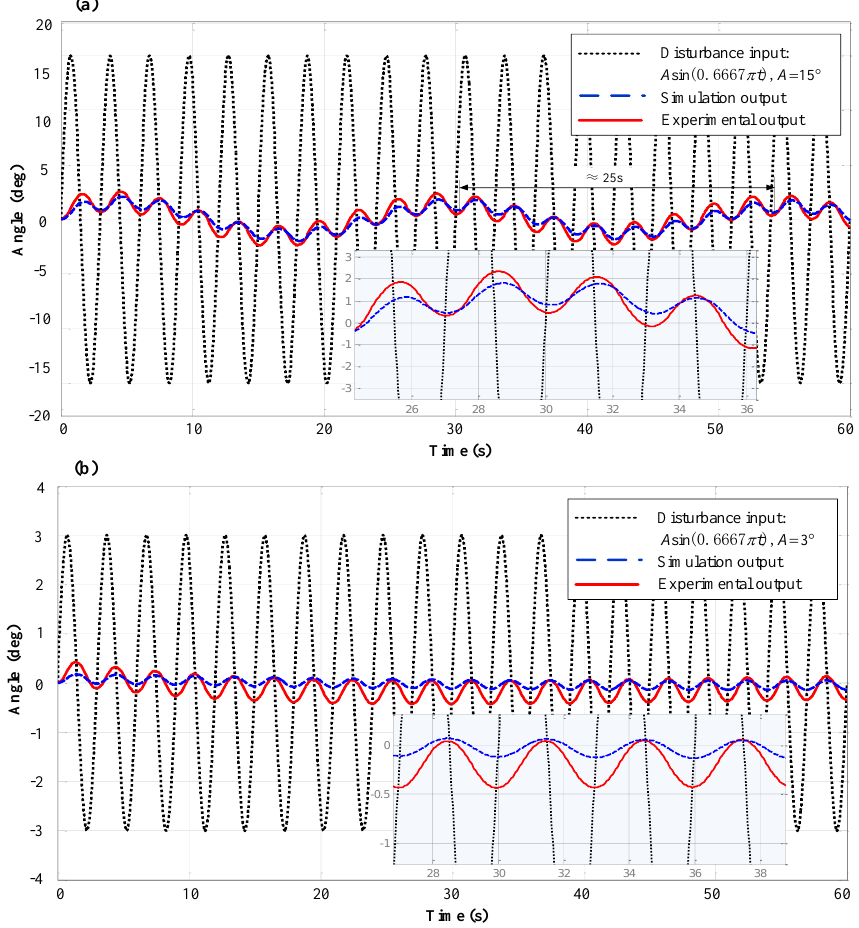
Figure 11. Simulation and experimental outputs at f = 0.3333. ( a ) A = 15°, simulation and experimental output; ( b ) A = 3°, simulation and experimental output.